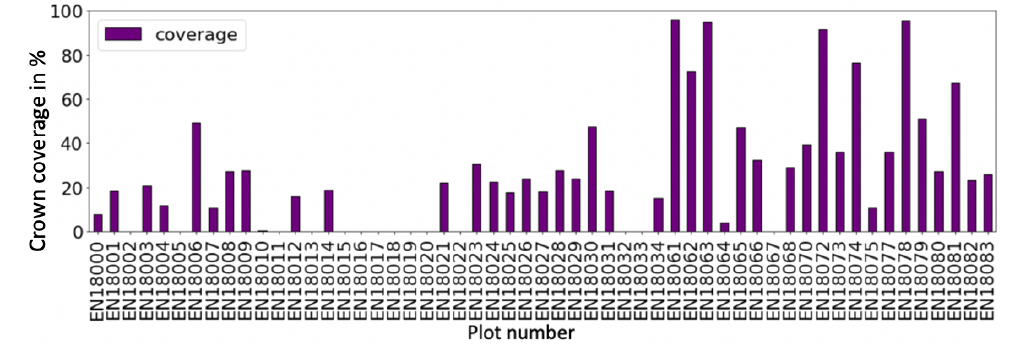
Figure 15. The percentage of the crown coverage in the orthomosaics per plot. A high percentage reflects a denser forest.